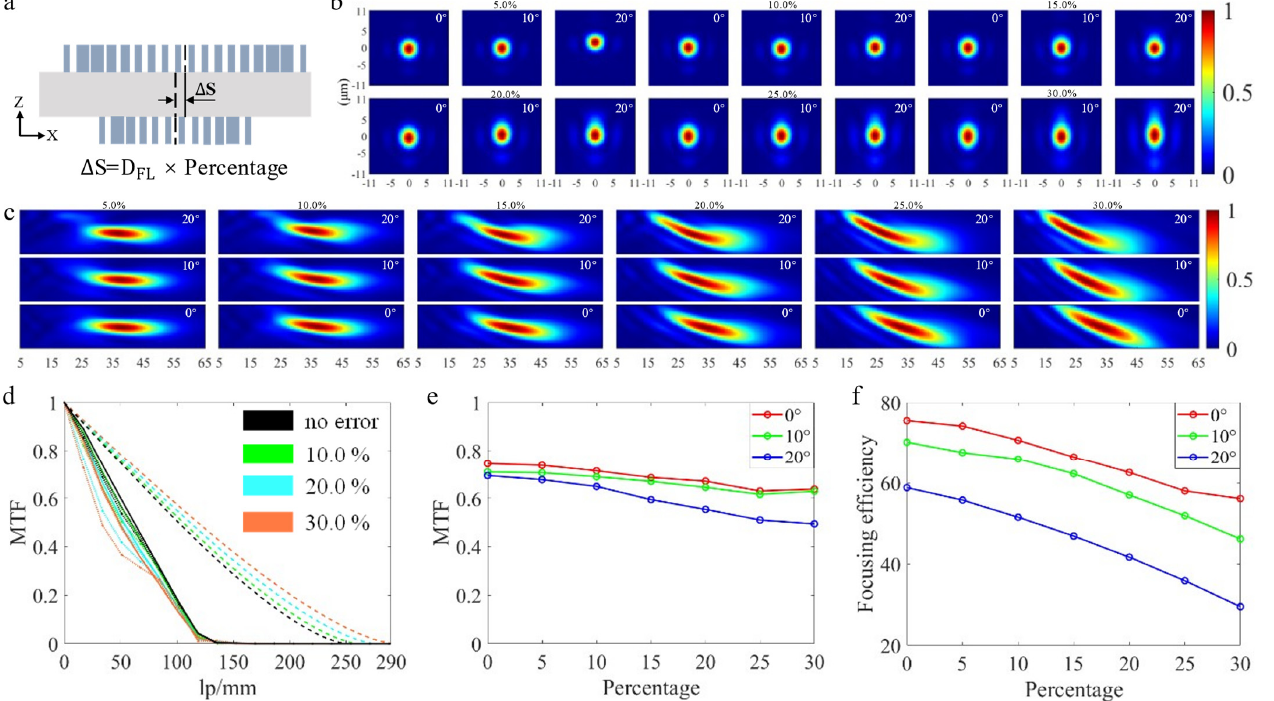
Figure 6. ( a ) Schematic diagram of interlayer alignment error. ( b , c ) Light intensity distribution along XY and XZ direction at different FOVs under various error conditions. ( d ) MTF curves at different FOV under various error and no − error conditions; the double dashed line represents the diffraction limit, the solid line represents the 0° FOVs; the dashed line represents the 10° FOVs; the dot − dashed line represents the 20° FOV. ( e ) Line chart of MTF values at different FOV under various error and no − error conditions, when the frequency is 33.33 lp/mm. ( f ) Focusing efficiency at different FOV under various error and no − error conditions.